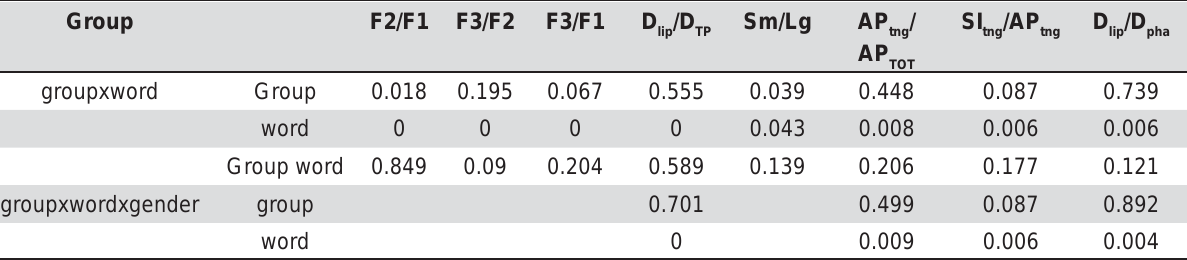
Table 2- Statistical analyses and p values